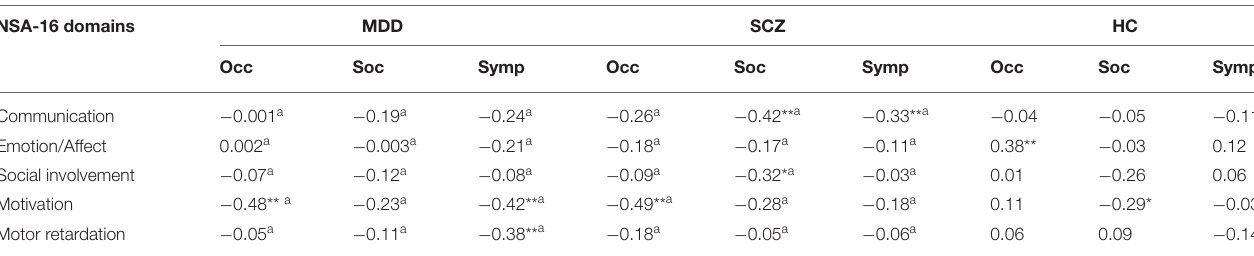
TABLE 3 | Correlations between MIRECC-GAF and NSA-16 domains between groups. NSA-16 domains